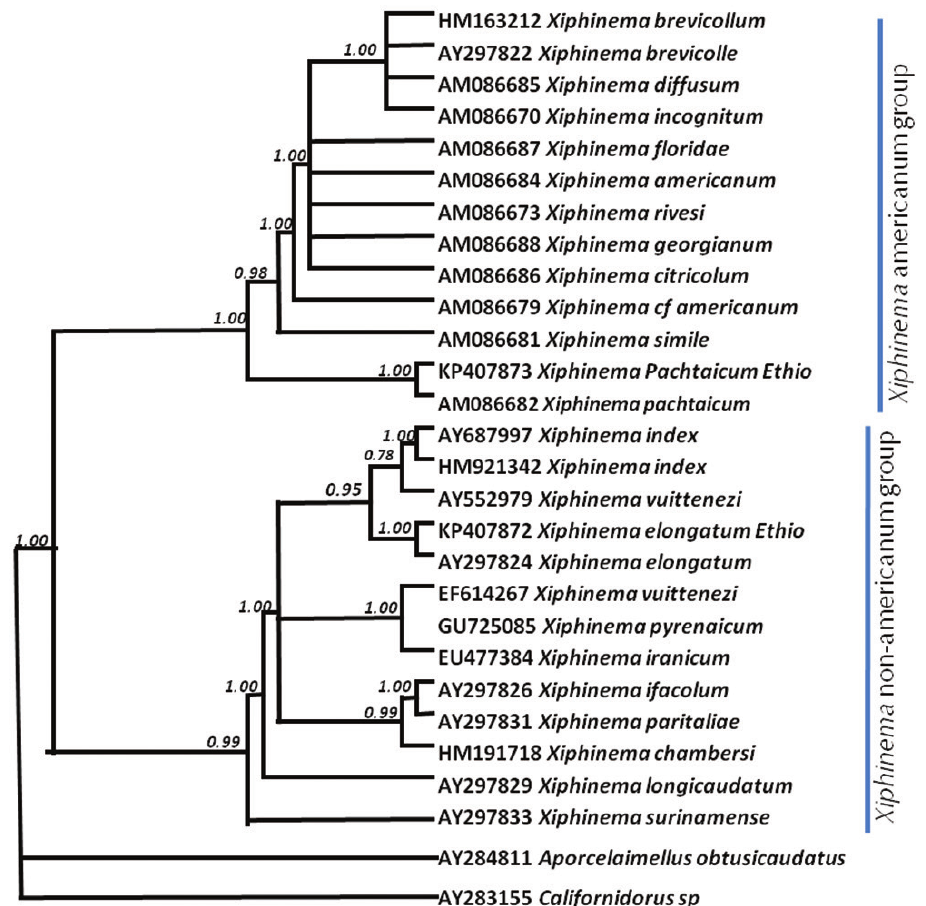
Figure 2. Phylogenetic relationships within Xiphinema species by Bayesian 50% majority rule consensus trees as inferred from 18S rRNA gene sequence alignments under the GTR + I + G